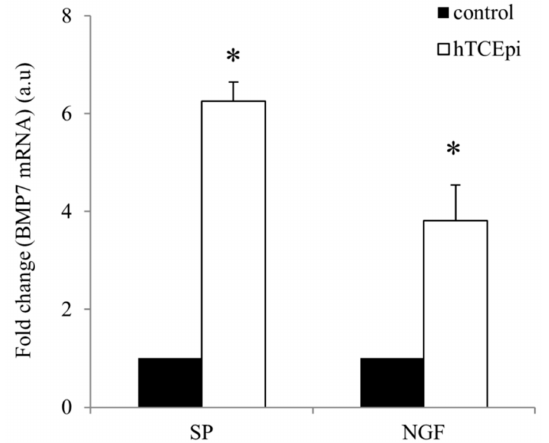
Figure 1. Relative expression levels of BMP7 mRNA in hTCEpi cells after treatment with SP (10 − 5 M) and NGF (100 ng/mL). Total RNA was isolated from SP and NGF treated hTCEpi cells after 24 h. Reverse transcription was performed using 1 µ g of total RNA to prepare cDNA and qRT-PCR was performed to find differences in the expression levels of BMP7 mRNA. Relative expression pattern was analyzed by the comparative threshold cycle (2 − ∆∆ C t ) method. Expression values were represented as fold change over the control on an arbitrary scale after normalization with GAPDH. Data represent mean ± standard deviation of three independent experiments. The p -values of <0.05 were considered statistically significant and are indicated by asterisks